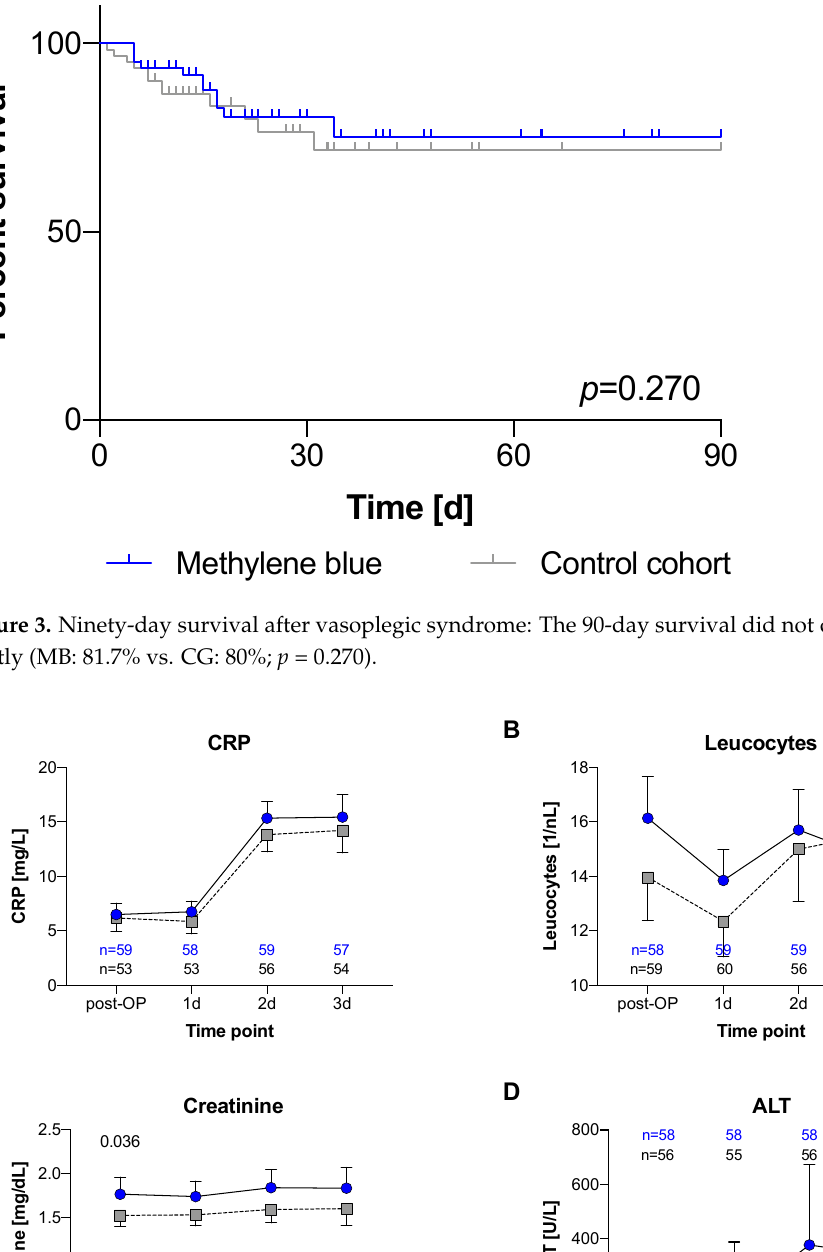
Figure 4. Postoperative variables: Variables are shown with regard to the use of methylene blue versus standard therapy (Matched Control), indicating mean (SD). ( A ) CRP; ( B ) Leucocytes; ( C ) Creatinine; ( D ) ALT.